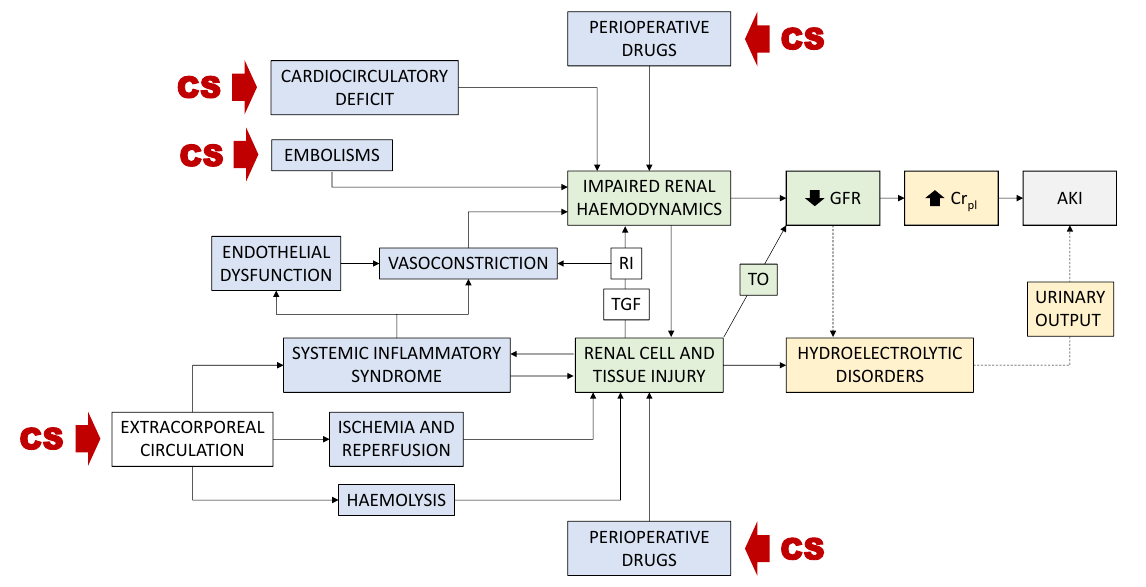
Figure 3. Pathophysiological mechanisms of CSA-AKI. AKI, acute kidney injury. Cr pl , plasma creatinine concentration. CS, cardiac surgery. GFR, glomerular filtration rate. RI, renal inflammation. TGF, tubuloglomerular feedback. TO, tubular obstruction.